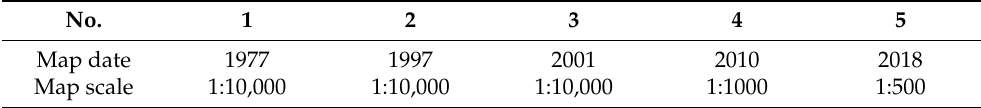
Table 2. Topographic maps adopted in the